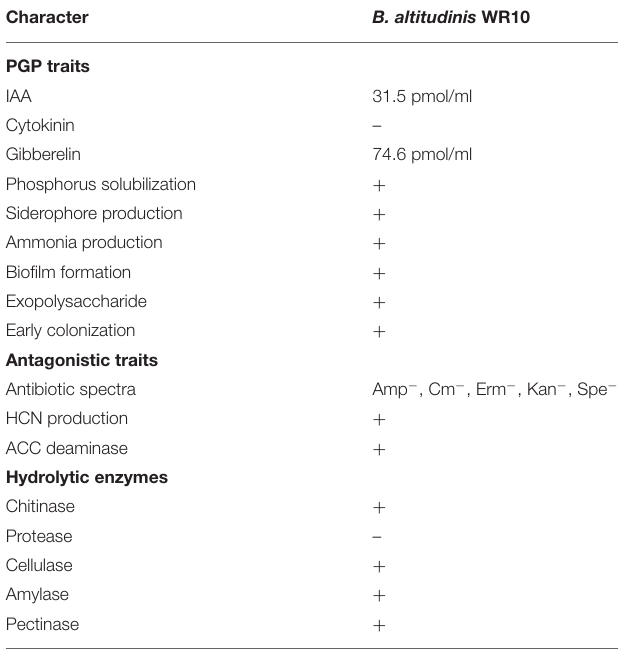
TABLE 1 | Production of enzymes and other characters of B. altitudinis WR10 related to plant growth-promoting (PGP) and